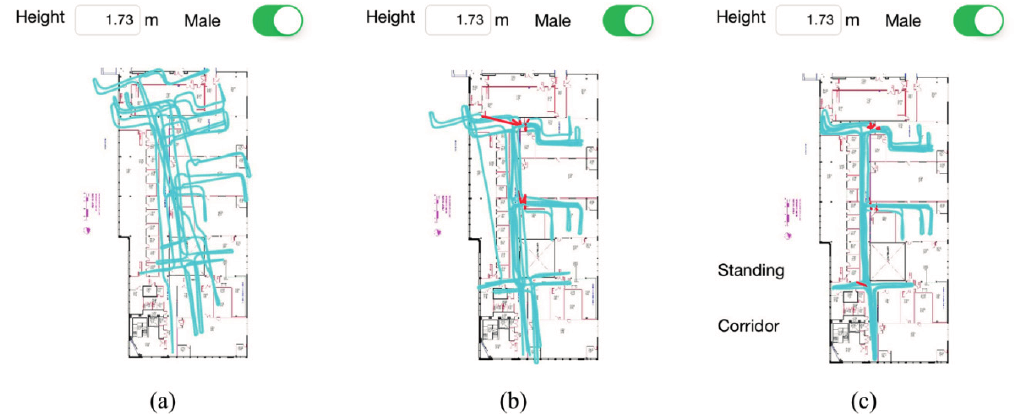
Figure 10. Tracking path of the long-term experiment ( a ) PDR standalone ( b ) PDR + SRP ADC ( c )